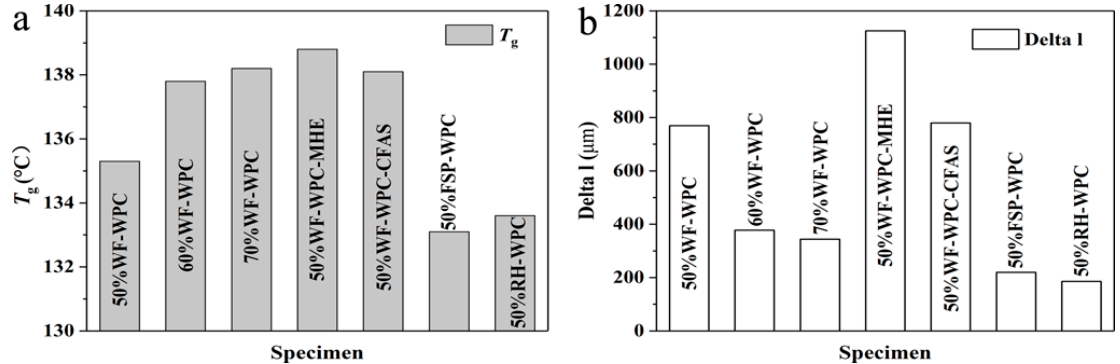
Figure 4. ( a ) The glass transition temperatures ( T g ) and ( b ) the deformation step heights of glass transition (Delta l).